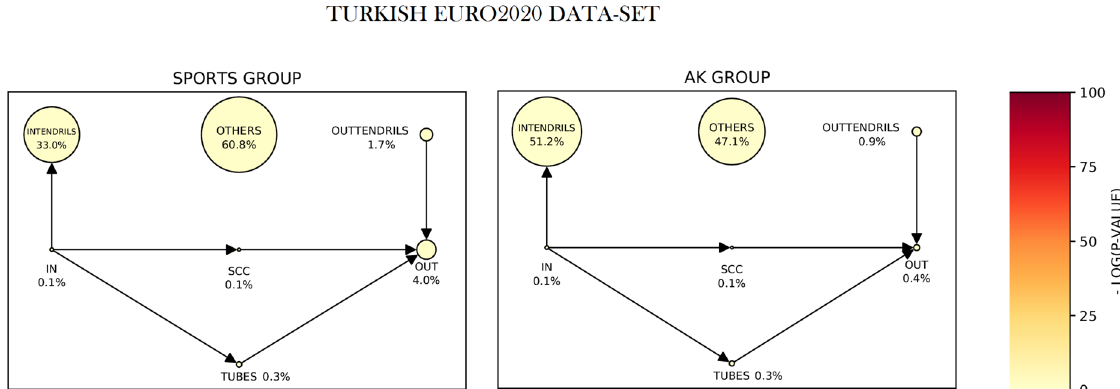
Figure 8. The bow-tie structure of the discursive communities for the Turkish EURO2020 dataset. The SPORTS group contains the official accounts of football players and clubs, and sports newspapers, while AK refers to the Justice and Development Party (Turkish: Adalet ve Kalkınma Partisi, AKP), which is a conservative political party in Turkey, including President Erdogan and his ministries. The SPORTS discursive community does not display an informative bow-tie structure, while the AK one has an extremely weak (INTEND-dominant) bow- tie. The dimension of the sectors is proportional to the number of nodes therein and the color quantifies the distance between the observed and the predicted dimension. Looking to the color of the vertices, it is possible to see that the observed dimensions are not statistically